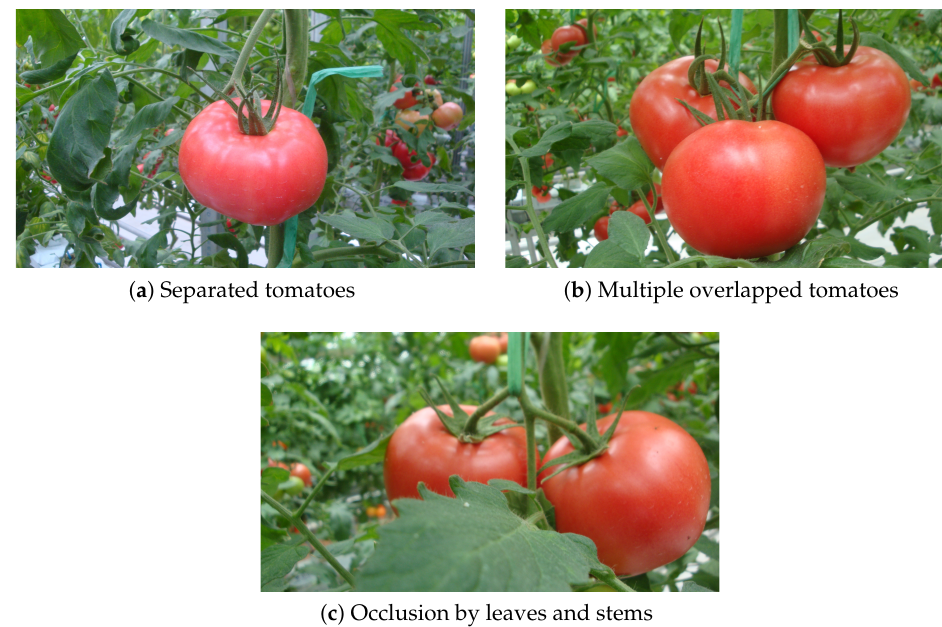
Figure 3. Images of tomatoes in different conditions: ( a ) separated tomatoes, ( b ) multiple overlapped tomatoes, and ( c ) occlusion by leaves and